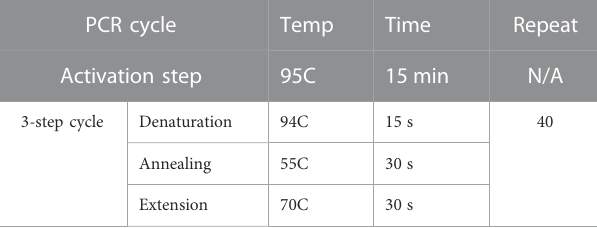
TABLE 2 qRt-PCR cycle conditions for miRNA